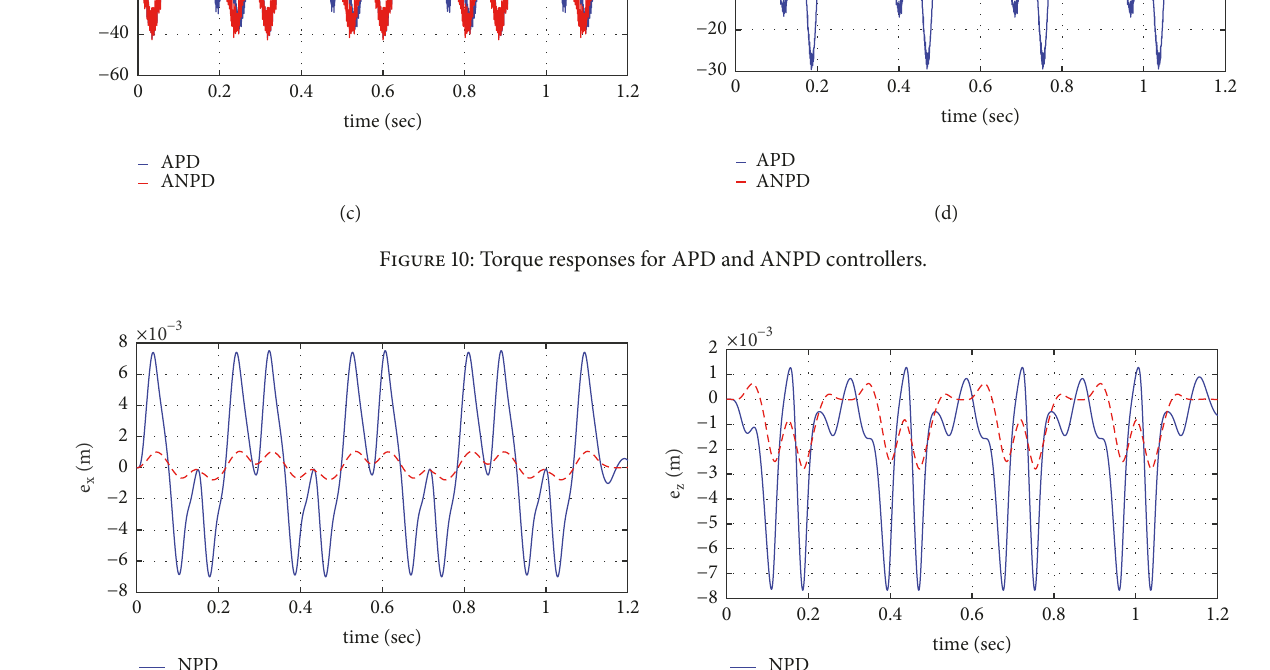
Figure 11: Cartesian error dynamic in 𝑥 - and 𝑧 -axes for NANPD and